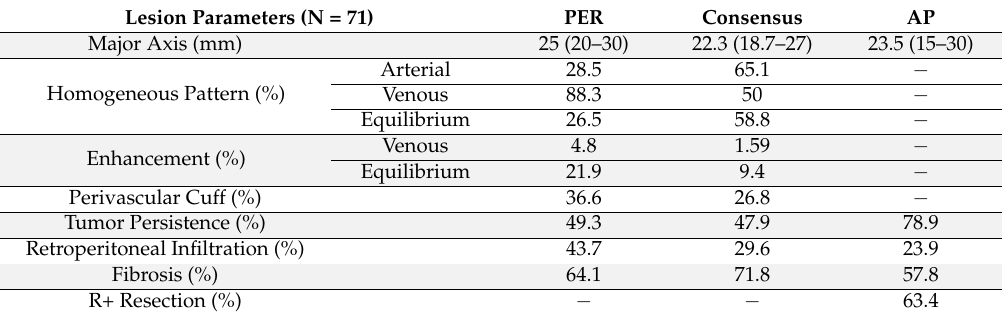
Table 2. Characteristics of lesions at PER single evaluation and consensus evaluation, compared to